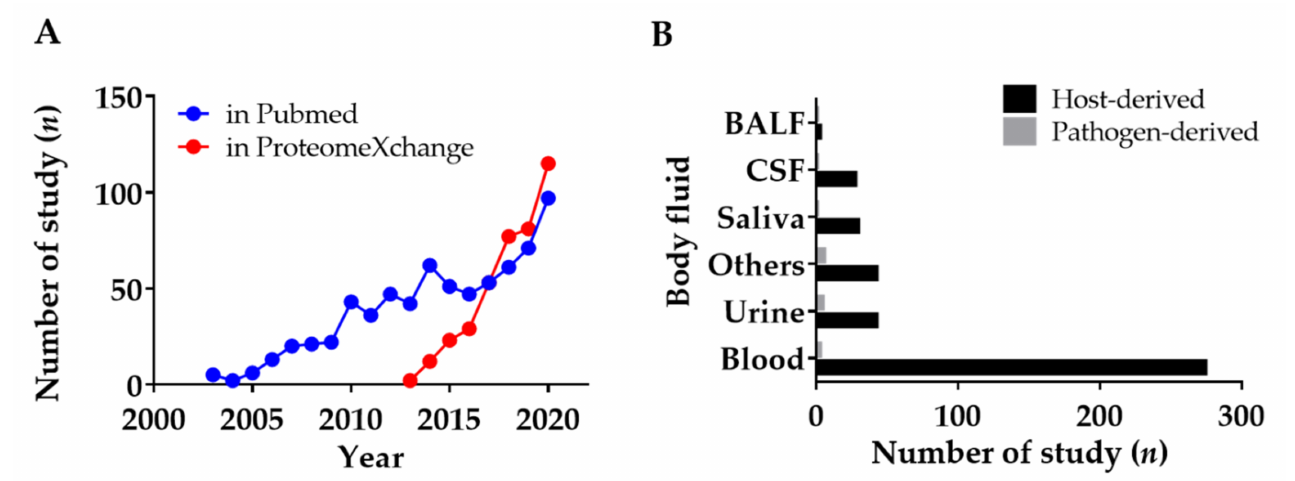
Figure 2. Current statistics of studies on body fluid proteomics for infectious diseases. ( A ) Gradual increases in research papers and deposited datasets on body fluid proteomics for infectious diseases.